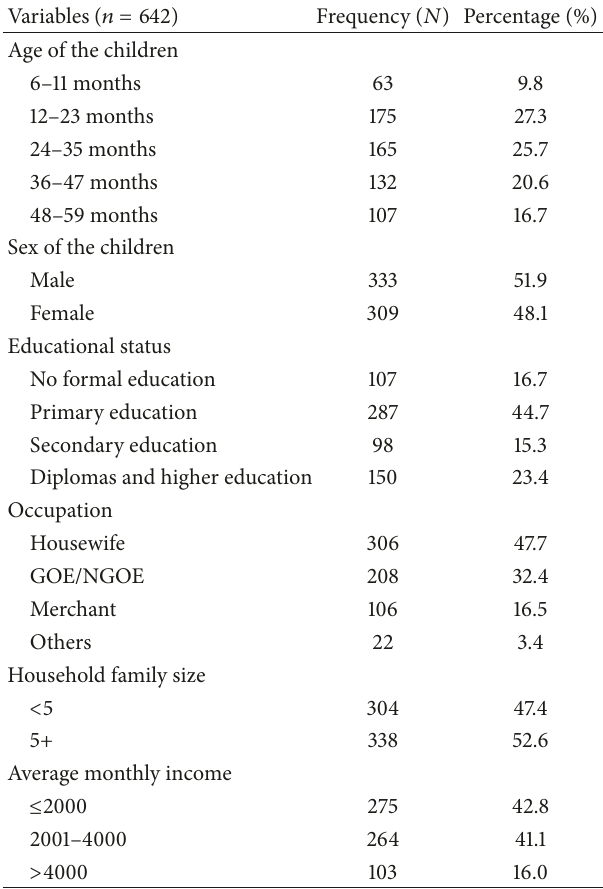
Table 1: Sociodemographic characteristics of respondents in Wolaita Sodo town, southern Ethiopia,